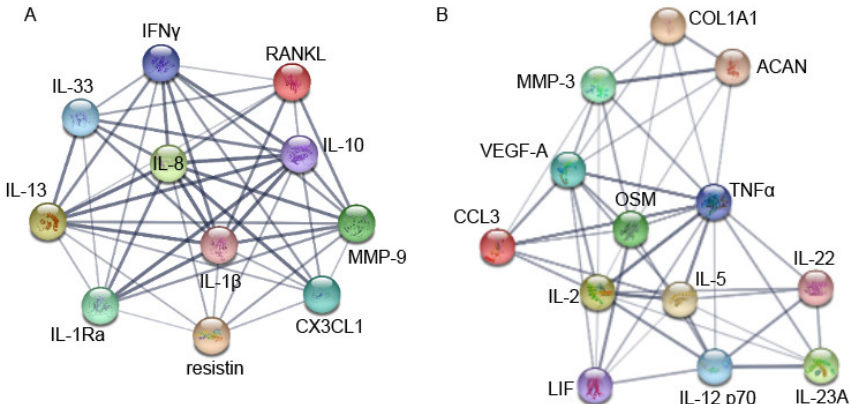
Figure 6. Protein–protein interaction analysis of the two identified groups by STRING database. Nodes represent proteins and the lines represent known interactions between the linked two proteins. The thickness of the lines indicates the confidence of the data which supports this interaction. Groups ( A ) and ( B ) are represented in the left and right panels, respectively. Color of nodes does not give information.